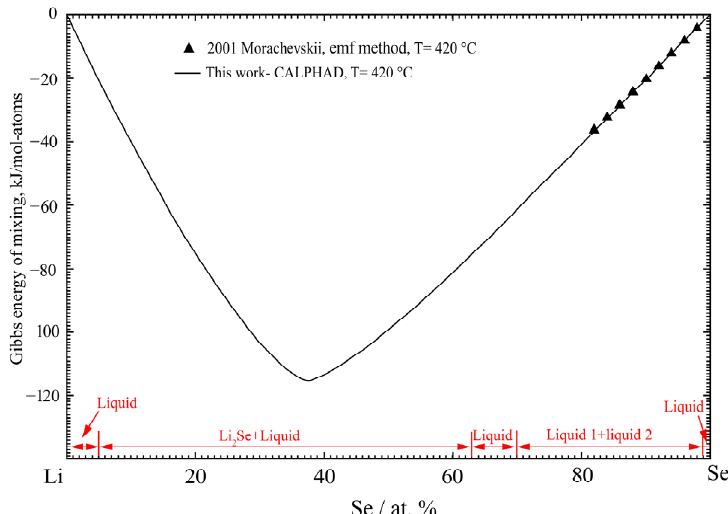
Figure 3. T he calculated Gibbs energy of mixing for the liquid phase of the Li-Se binary system at 420 °C compared with the reported results by Morachevskii